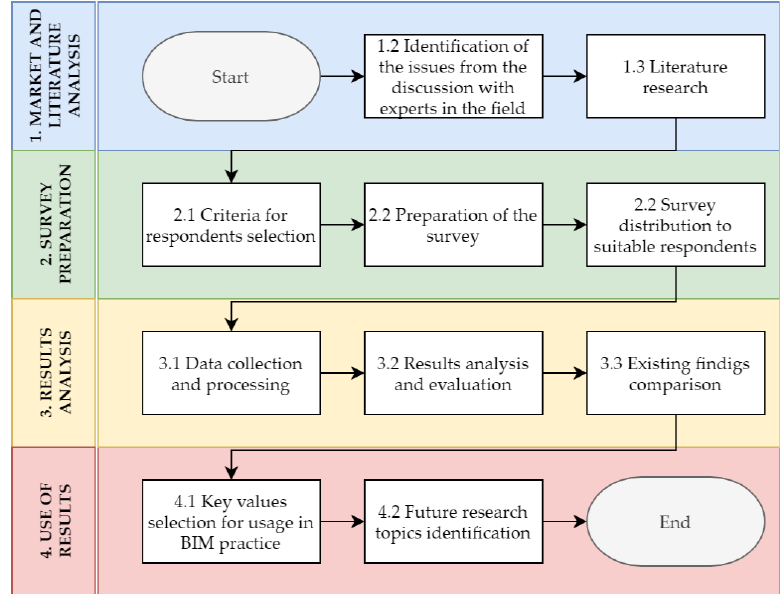
Figure 2. Process map of the research